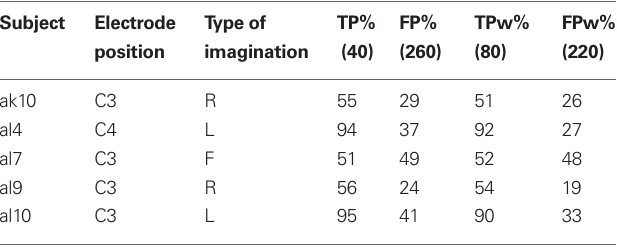
Table 4 | results of pulse-width modulated brain switch during six runs (total 30 min) platform game.